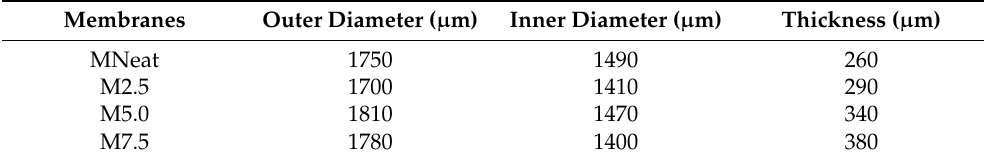
Table 2. OD, ID and thickness of the neat PVDF and different concentrations of ZnO/PVDF membranes. Membranes Outer Diameter ( µ